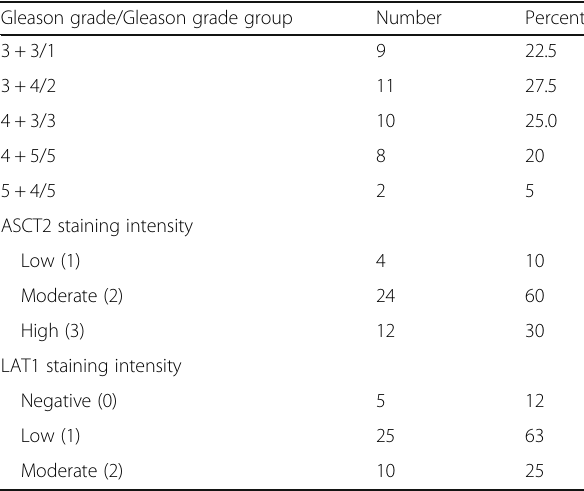
Table 1 Histological characteristics and findings at immunohistochemistry evaluating amino acid transporter expression of 40 tumor foci in 25 patients with localized prostate cancer. Note that no tumors were assigned in